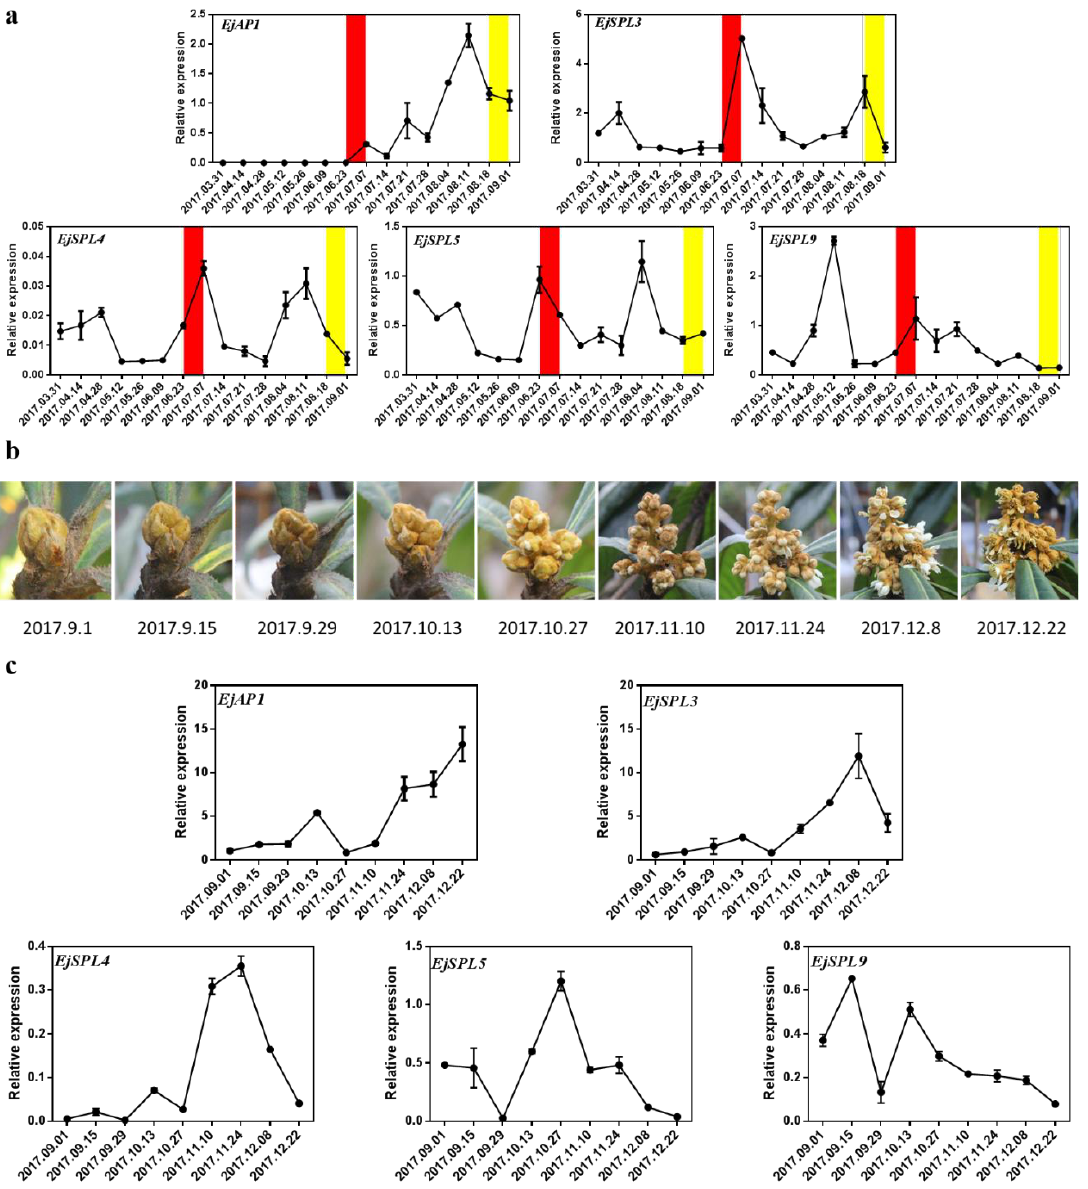
Figure 5. Relative expression levels of EjSPL genes in the buds and flowers of “JFZ” at di ff erent periods. ( a ) Relative expression levels of EjSPL genes in the buds at di ff erent periods. ( b ) The flowers in di ff erent developmental stages. ( c ) Relative expression levels of EjSPL genes in ( b ). Red box and yellow box indicated the beginning of flower bud di ff erentiation and the obvious inflorescence that can be seen, respectively. Ej β -actin as an internal control. Error bars indicating SE from three biological replicates.